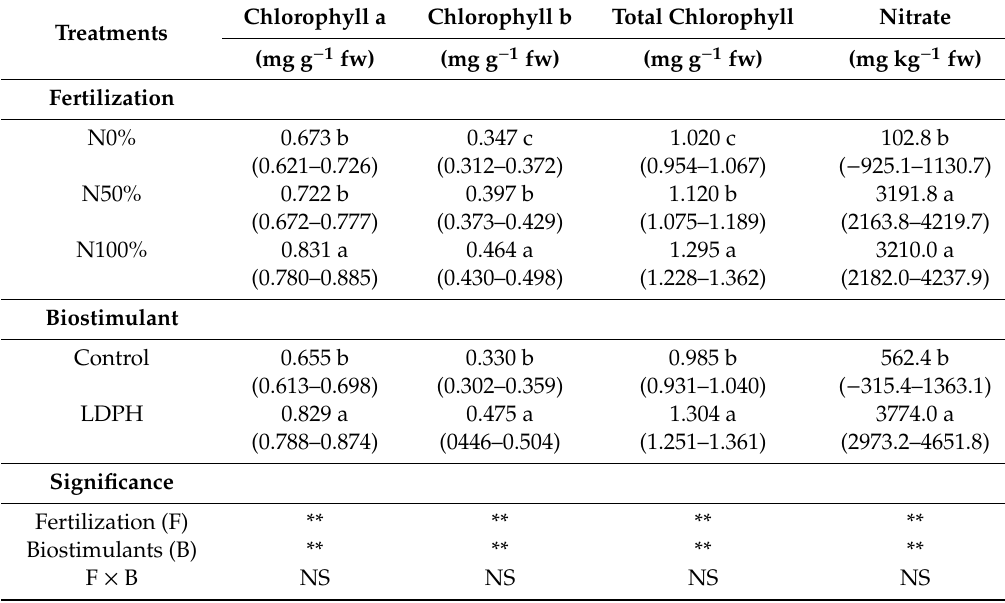
Table 4. Chlorophyll a and b, total chlorophyll and nitrate content of lamb’s lettuce plants as a ff ected by nitrogen (N) fertilization levels (0, 2.5 and 5.0 g N m − 2 ; N0%, N50%, N100%, respectively) and biostimulant applications (control and LDPH: Legume-derived protein